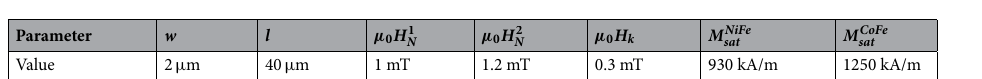
1,2 off , SV 2 pinned layer